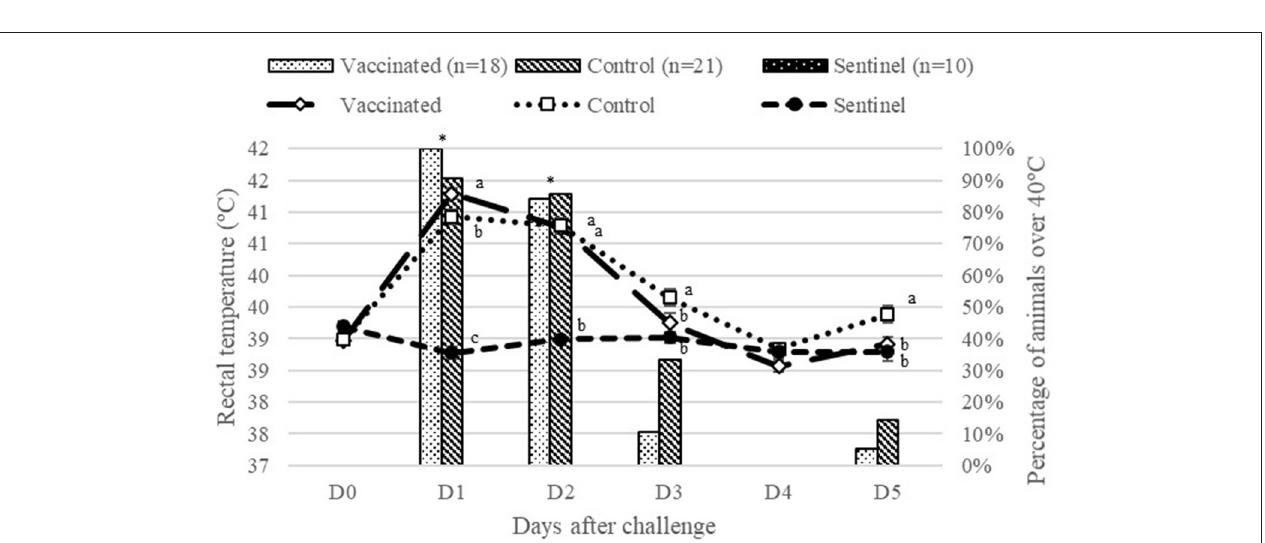
FIGURE 4 | Average of rectal temperatures and percentage of animals with temperatures over 40 ◦ C from vaccinated and control groups from challenge to day 5 after experimental infection. Different superscript letters ( a , b , c ) indicate significant differences ( P < 0.05) between groups in terms of rectal temperatures ( ◦ C) per day. *Indicates significant differences ( P < 0.05) between infected groups (vaccinated and control) compared to the sentinel group in terms of percentage of animals over 40 ◦